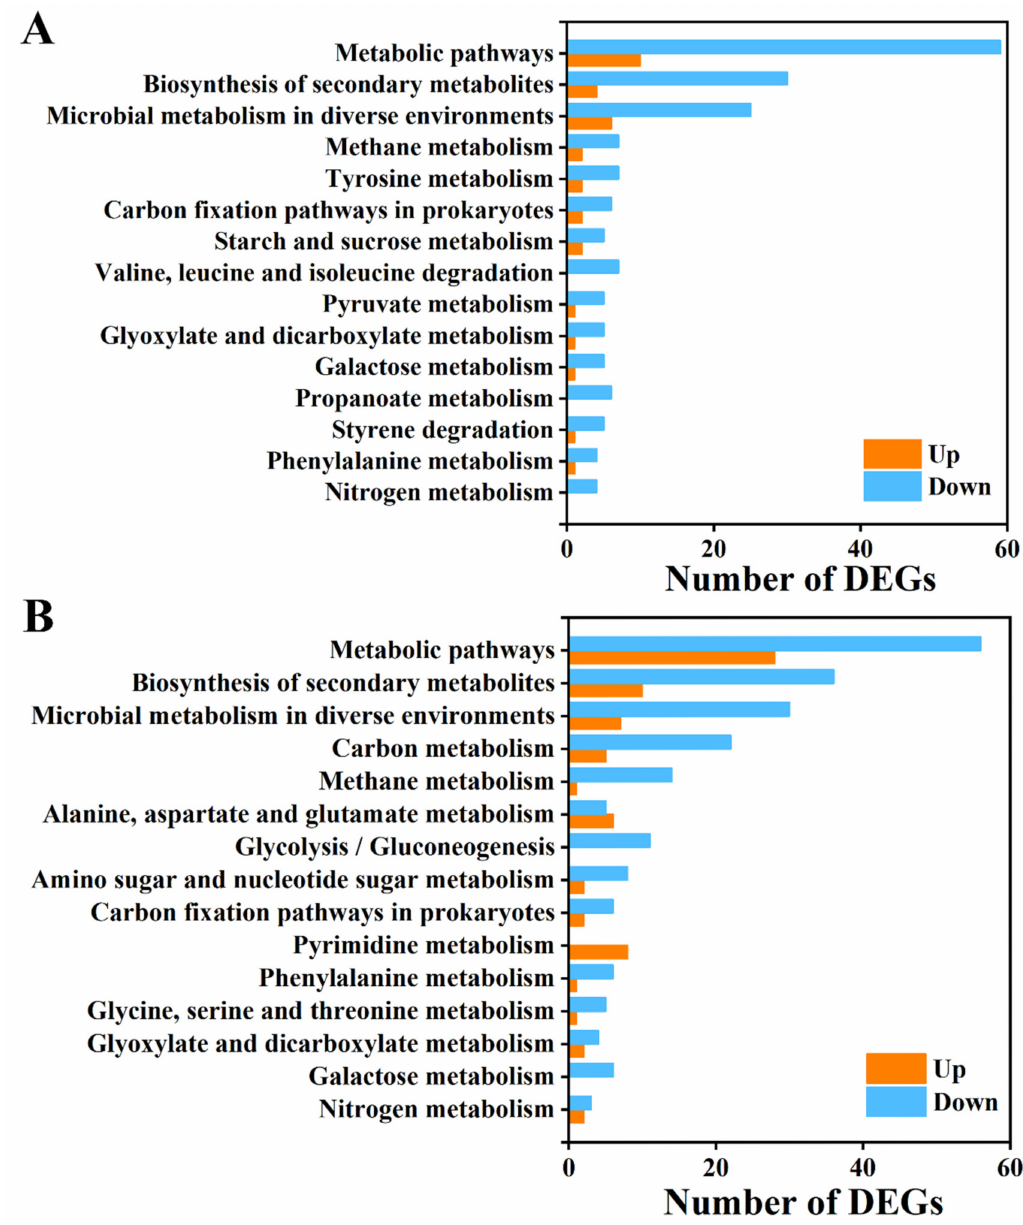
Figure 7. KEGG signal pathway enrichment analysis of differential genes in F. oxysporum treated with 25 ( A ) and 50 ( B ) µ g/mL iturin